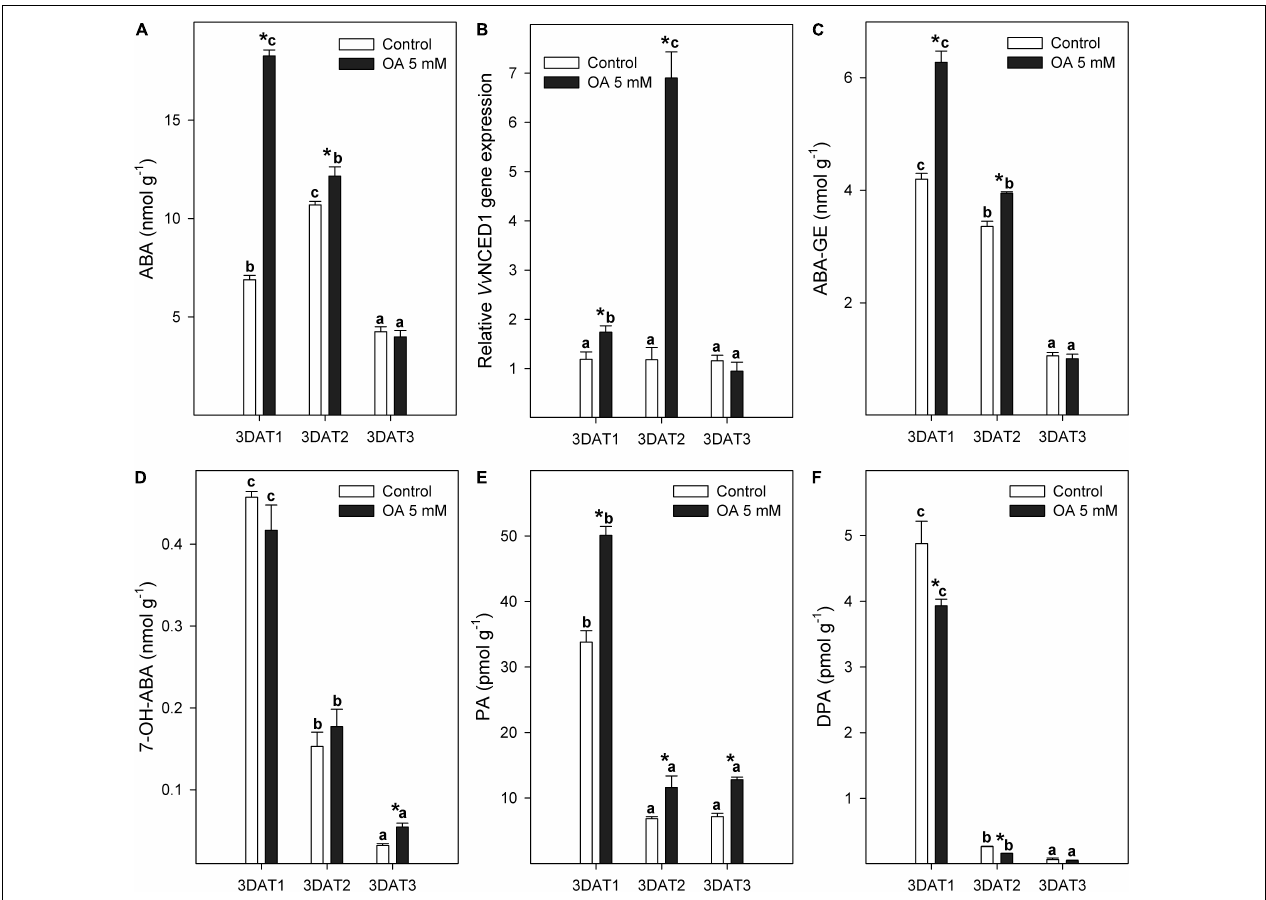
FIGURE 1 | Evolution of ABA berry content (nmol g − 1 ) (A) , relative Vv NCED1 gene expression (B) , and ABA catabolites [ABA-GE (C) , 7-OH-ABA (D) , PA (E) , and DPA (F) ] content (nmol or pmol g − 1 ) measured in control and 5 mM oxalic acid (OA)-treated ‘Magenta’ table grapes during three key growth and ripening stages in preharvest: 3DAT1 (3 days after the first treatment when berries reached ca. 40% of its final size), 3DAT2 (3 days after the second treatment when veraison stage started), and 3DAT3 (3 days after the third treatment, at harvest). Data are the mean ± SE. Significant differences ( p < 0.05 according to Student’s t -test) between control and OA-treated berries were expressed as * symbol placed in the OA bar for each stage and parameter. Different lowercase letters show significant differences ( p < 0.05 according to HSD Duncan’s test) among the three stages during berry development. Vv NCED1, Vitis vinifera 9- cis